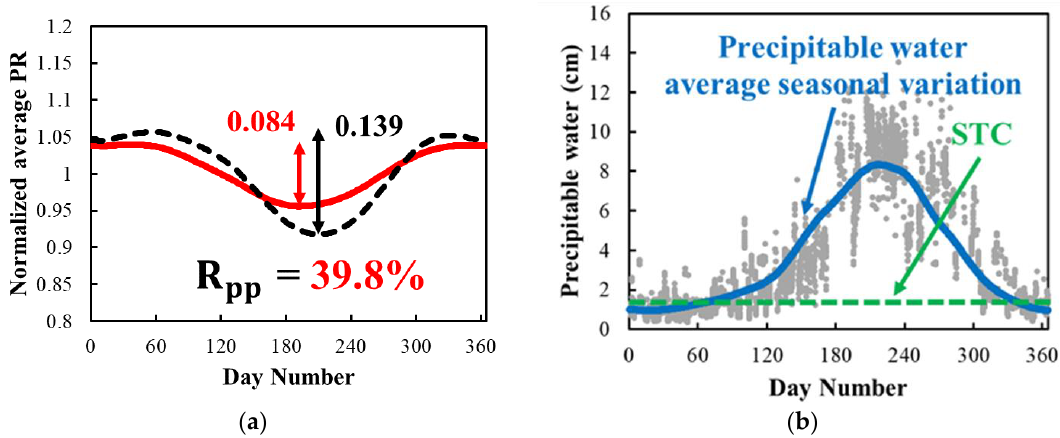
Figure 7. Comparison of the annual output between 4T configuration and 2T configuration affected by the variation of the atmospheric parameter: ( a ) Predicted seasonal fluctuation of the normalized energy yield of 4T (red and solid line) and 2T (black and dashed line) configuration; ( b ) Seasonal variation of precipitable water (optical depth) in our measurement that is likely to be responsible for the difference of behavior between 2T and 4T configuration. Note that this chart is identical to Figure 4b [99]. Table 3. Summary of the outdoor performance of 4T on-Si tandem solar cell and normal 2T three- junction tandem solar cell.